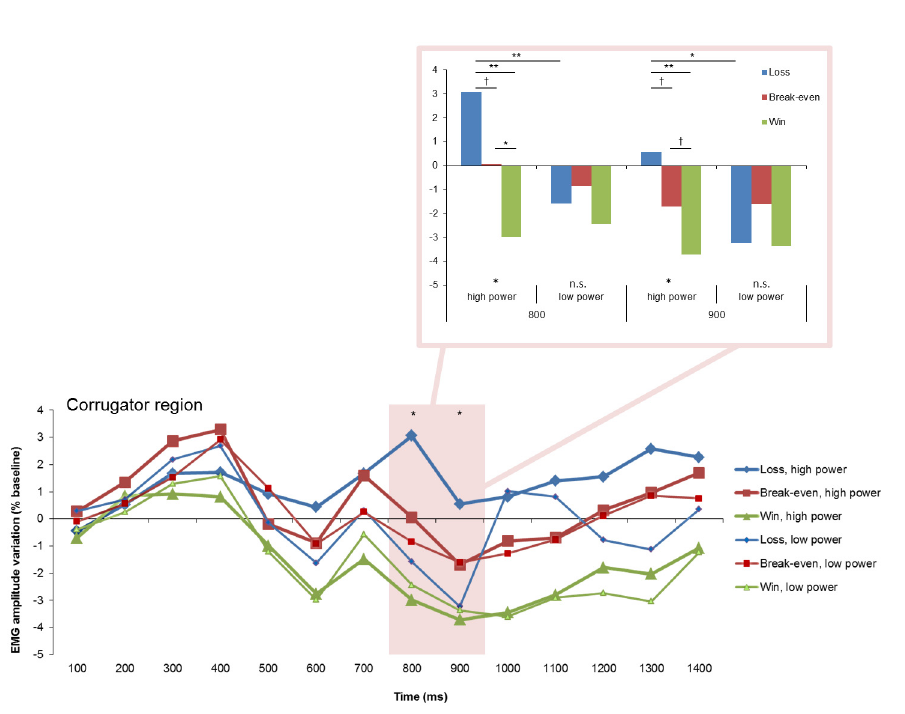
Fig 5. Electromyographic (EMG) amplitude variations over the corrugator region, illustrating the interaction of goal conduciveness and power appraisals across time. † p < .10, * p < .05, ** p <